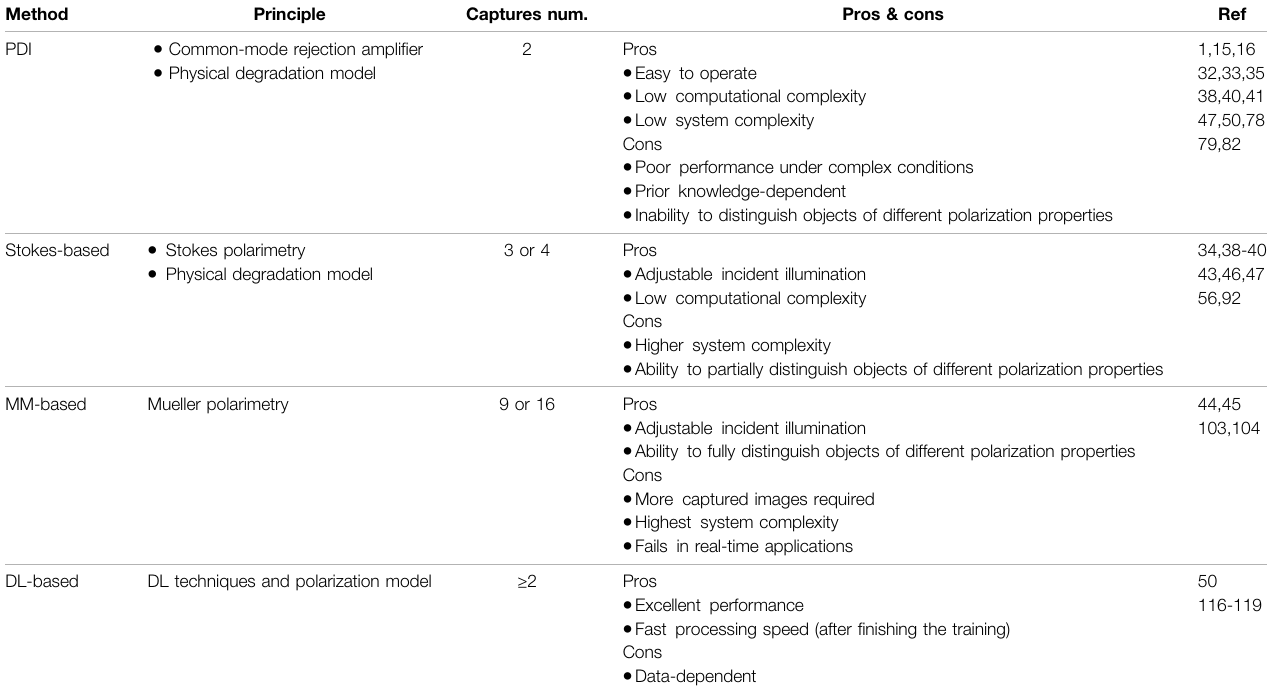
TABLE 1 | Summary of polarimetric de-scattering methods.